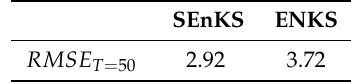
Figure 21. EnKS approach: Realizations from the posterior distribution of the initial temperature field f ( r 0 | d 0: T ) at time T = 50. Upper panels: the colorbar gives the temperature in ◦ C. Lower panels: the horizontal axes represent the temperature ( ◦ C), the vertical axes represent the relative prevalence of each temperature value for the realization right above. Table 4. RMSE comparing the MMAP prediction of the initial temperature field and the initial temperature field at time T =